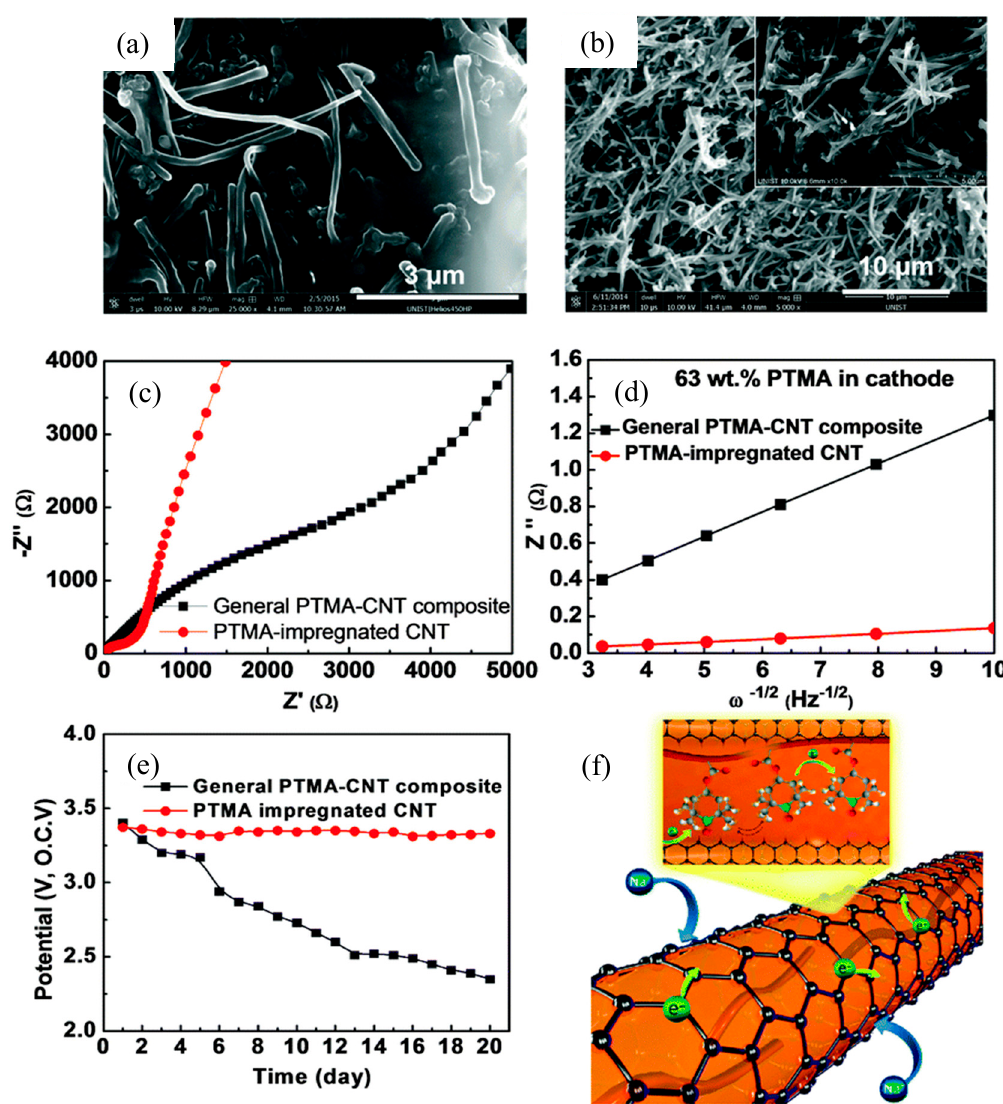
Figure 9. Scanning electronic microscopy images of ( a ) PTMA-CNT composite and ( b ) PTMA-impregnated CNT electrodes; ( c ) impedance spectra and ( d ) the relationship between the imaginary resistance and the square root of frequency in the low-frequency region, ( e ) open circuit voltage during twelve days of PTMA-CNT composite and PTMA-impregnated CNT electrodes as candidate cathode materials for sodium-ion batteries; ( f ) schematic illustration of the PTMA-impregnated CNT structure. Adapted from [71], with permission from © 2008 Royal Society of Chemistry.